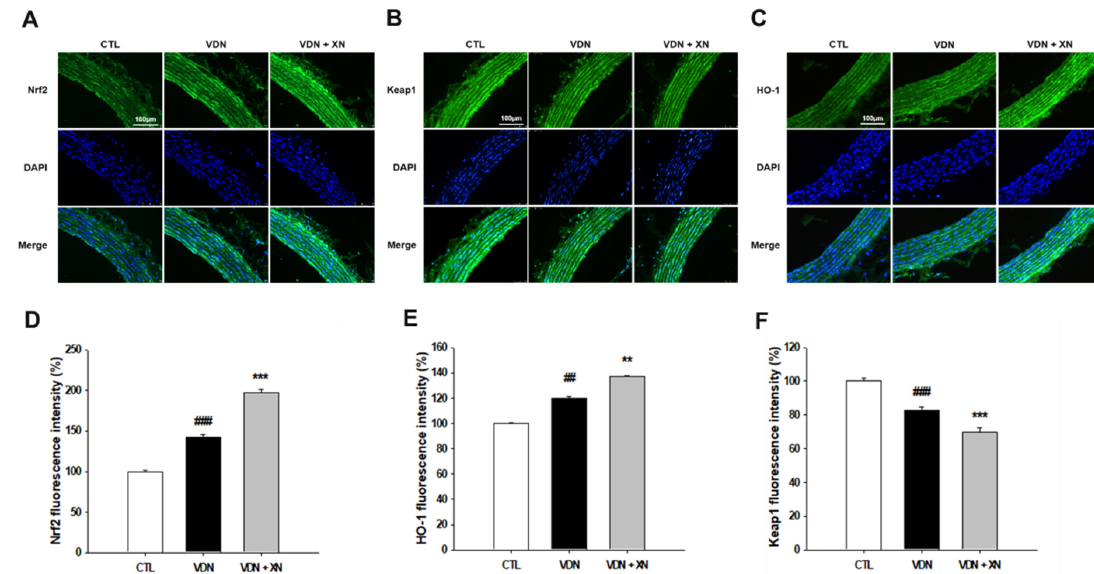
Figure 9. Effects of XN on the expressions of Nrf2, HO-1, and Keap1 through confocal microscopic evaluation of nuclear thoracic aorta wall. ( A ) Nrf2, ( B ) HO-1, ( C ) Keap1, ( D ) quantified Nrf2 fluorescence intensity, ( E ) quantified HO-1 fluorescence intensity, and ( F ) quantified Keap1 fluorescence intensity, relative to number of nuclei. Counterstaining of nuclei with DAPI in blue was merged into all images. Each point represents the mean ± SEM, n = 6. ## p < 0.01, ### p < 0.001 compared with the control group. ** p < 0.01, *** p < 0.001 compared with VDN